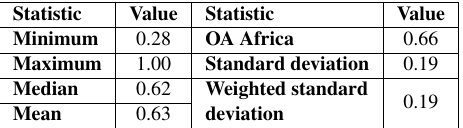
Table 5. Summary statistics of OA in African countries